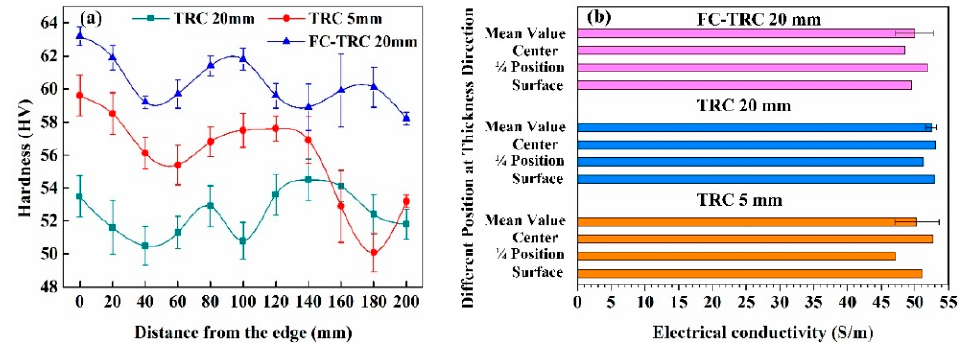
Figure 10. Hardness and electrical conductivity of TRC sheets of di ff erent processing